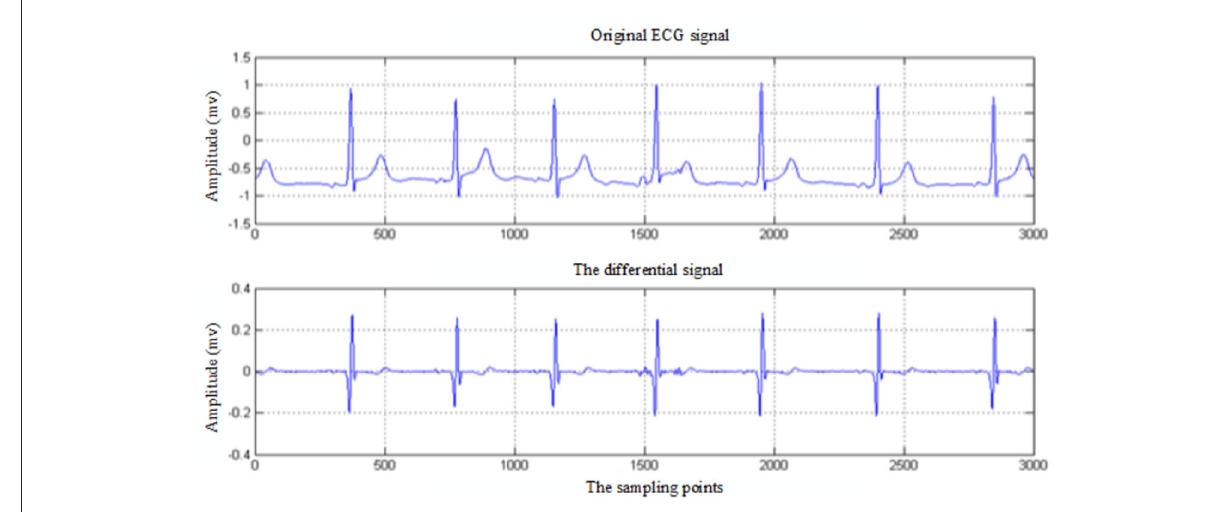
FIGURE3 Comparison between the original ECG signal and differential signal.